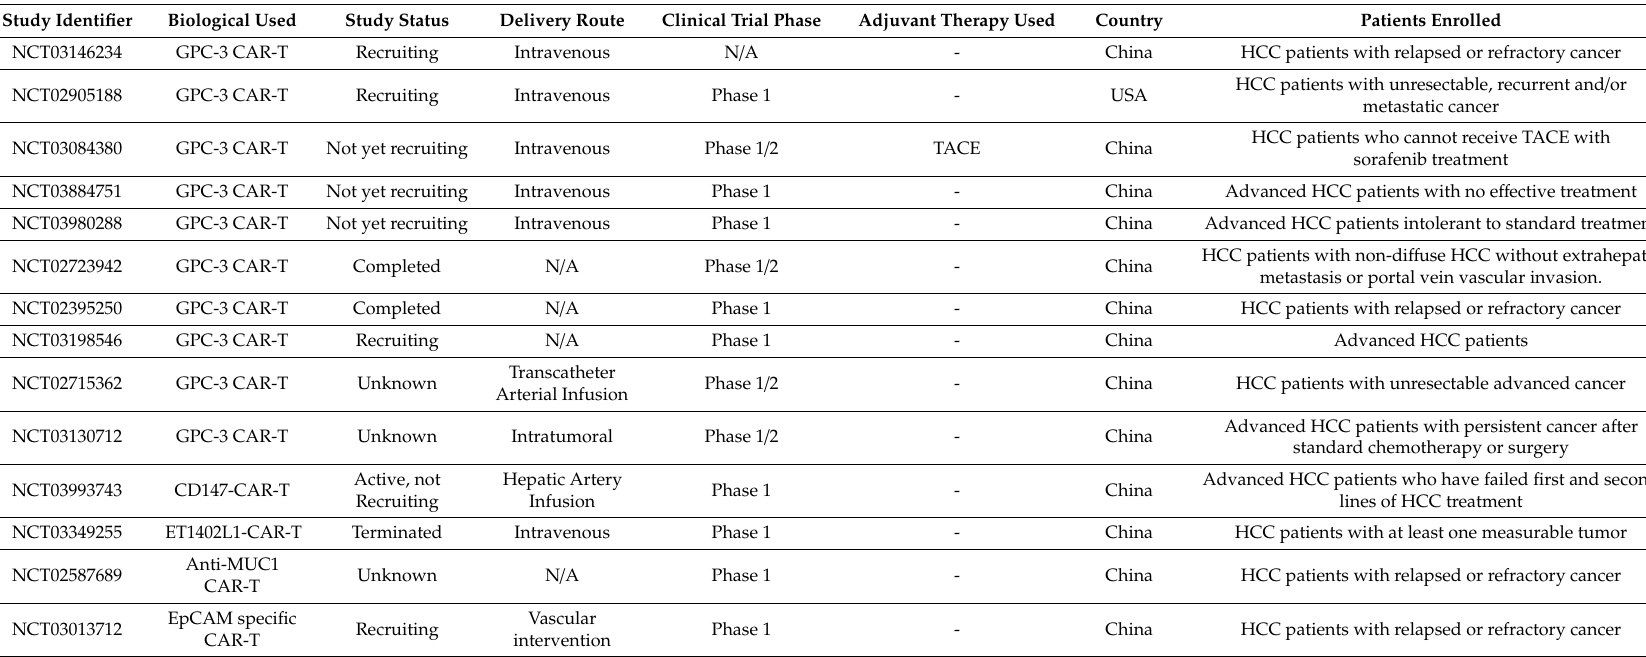
Table 1. Data from clinicaltrials.gov as of 07.13.2019 showing clinical trials that use Chimeric Antigen Receptor T (CAR-T) cells to treat Hepatocellular Carcinoma